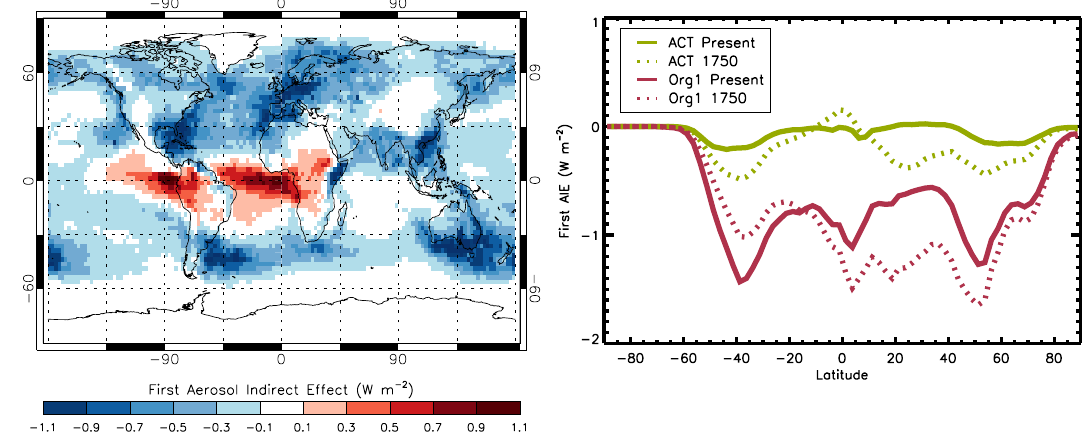
Fig. 10. Left: annual mean first AIE from biogenic SOA when anthropogenic emissions from 1750 are included in GLOMAP. Right: annual zonal mean first AIE from biogenic SOA in present-day (solid lines) and pre-industrial (dashed lines) simulations when the ACT (green) and Org1 (red) nucleation mechanisms are